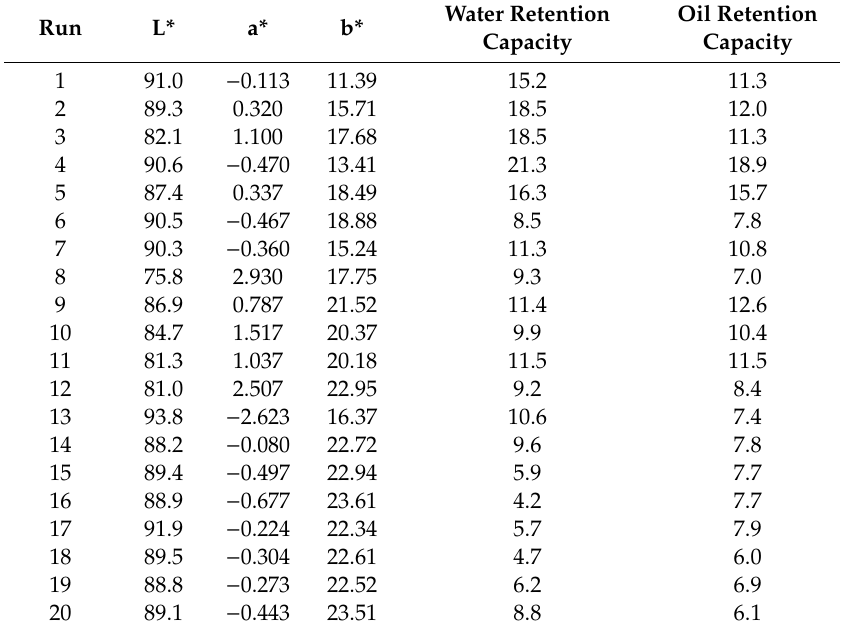
Table 4. Yield, water and oil retention capacity and color parameters a obtained for the di ff erent runs used for the optimization